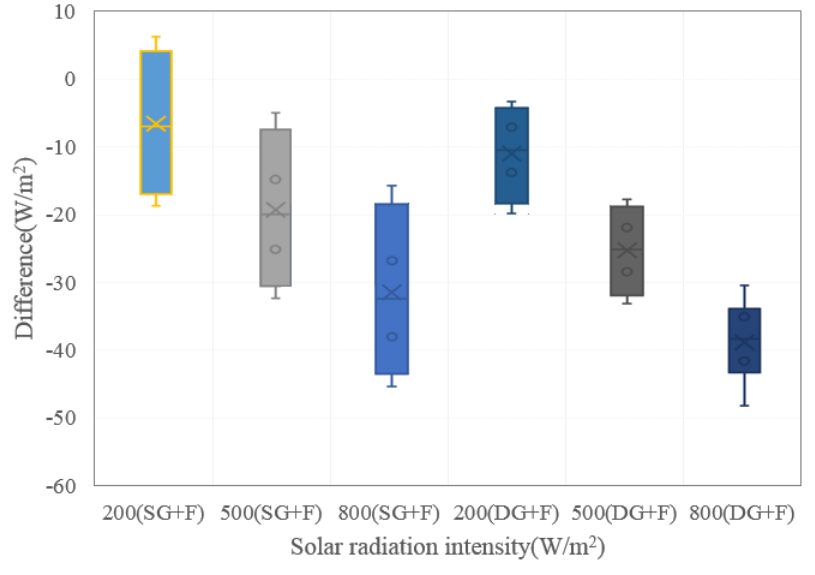
Figure 5. The difference between Q ca and Q t .